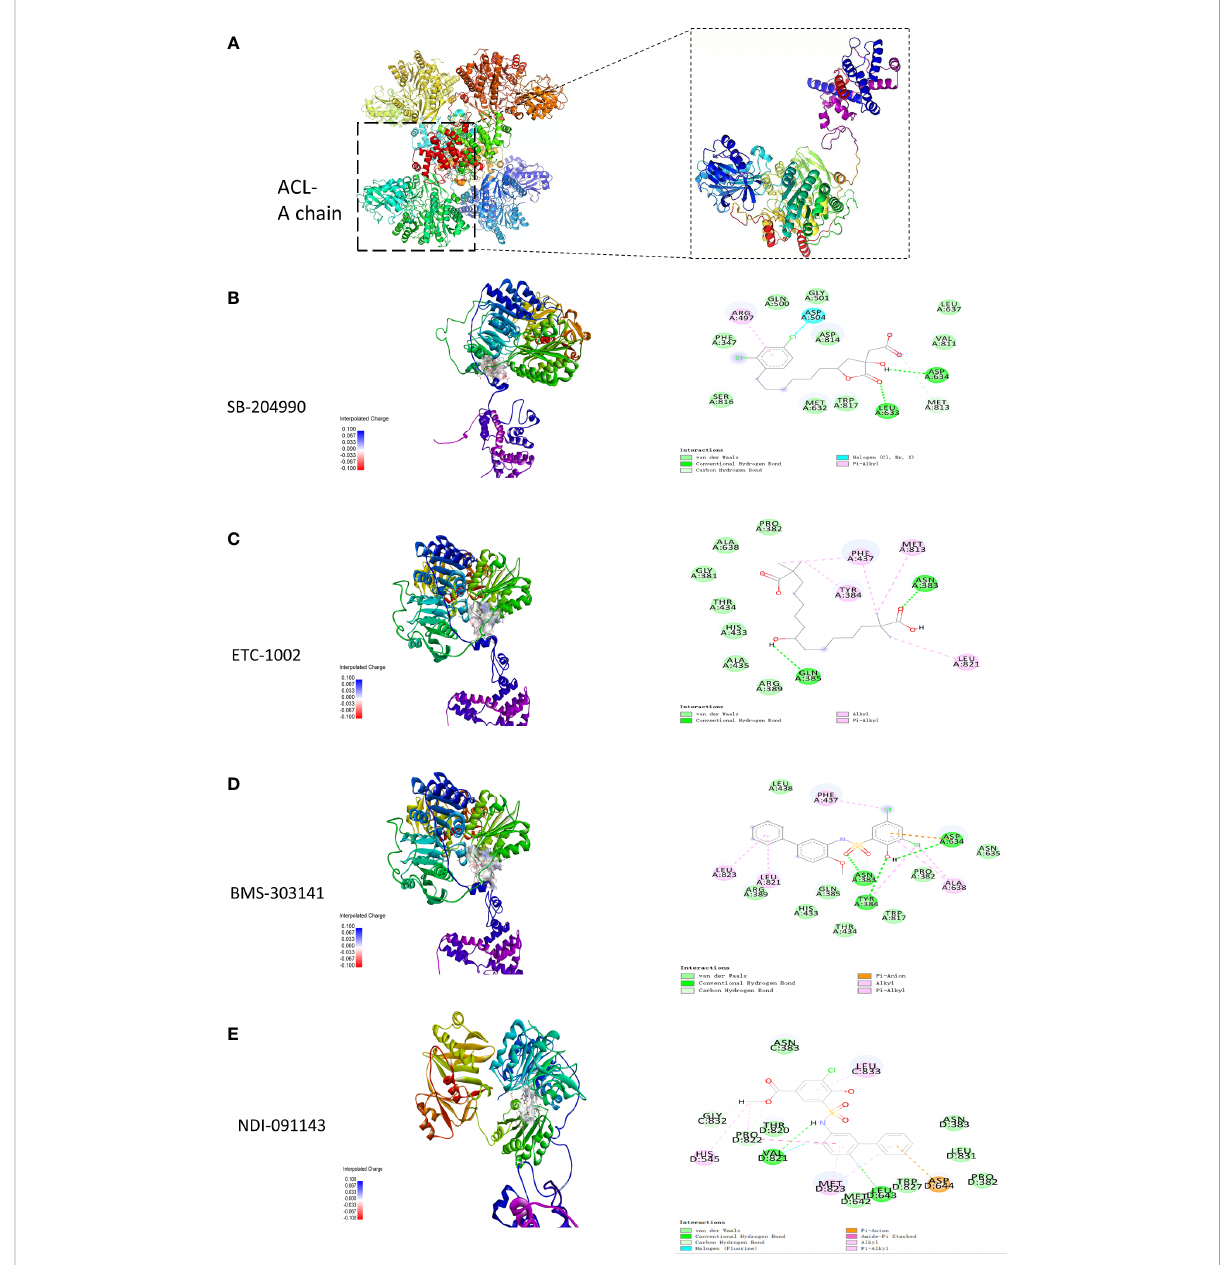
FIGURE 1 (A) Three-dimensional structure of ACL. (B-E) Modeled interactions of SB-204990, ETC-1002, BMS-303141, and NDI-091143 with ACL and the docking binding pocket of chemicals with ACL after homology modeling. The chemical in the binding model has been covered with spheres. Amino acid residues of ACL that participated in binding models are shown in green and